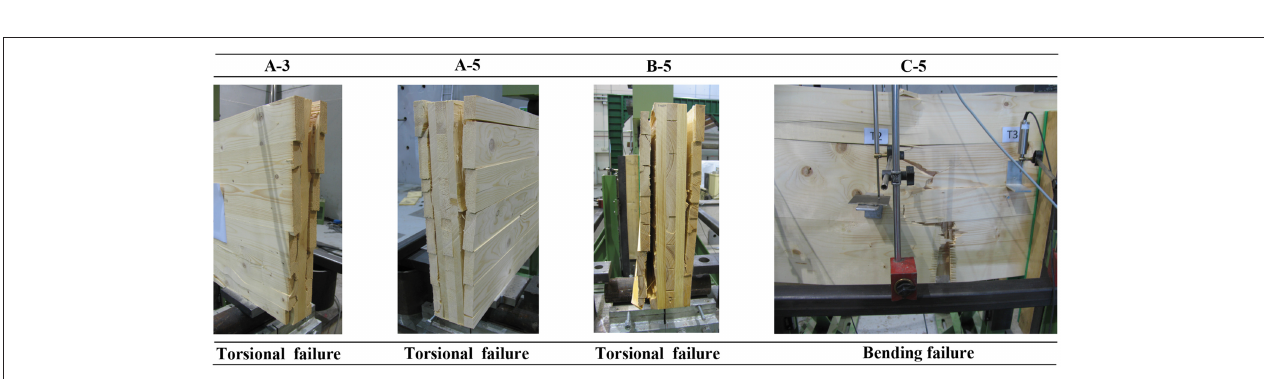
FIGURE 7 | Comparison of shear stresses at failure. Note that for the RVSE method there is no value for τ xy since this method only provides the value of major stress τ yx . Note also that for 5 layer panels the equilibrium method provides two values of τ T , one for the external and one for the internal glued interface.